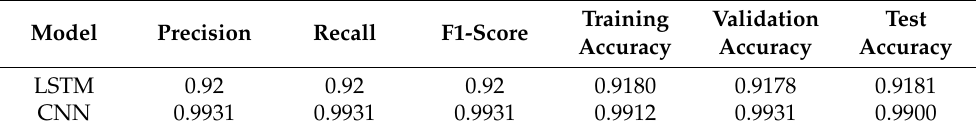
Table 3. Performance metrics for the best performing model (LSTM) applied to the 14 MFCC features, and the CNN models applied to the STFT spectrograms. Please note the Precision, Recall and F1-scores given are for the models applied to the validation dataset.